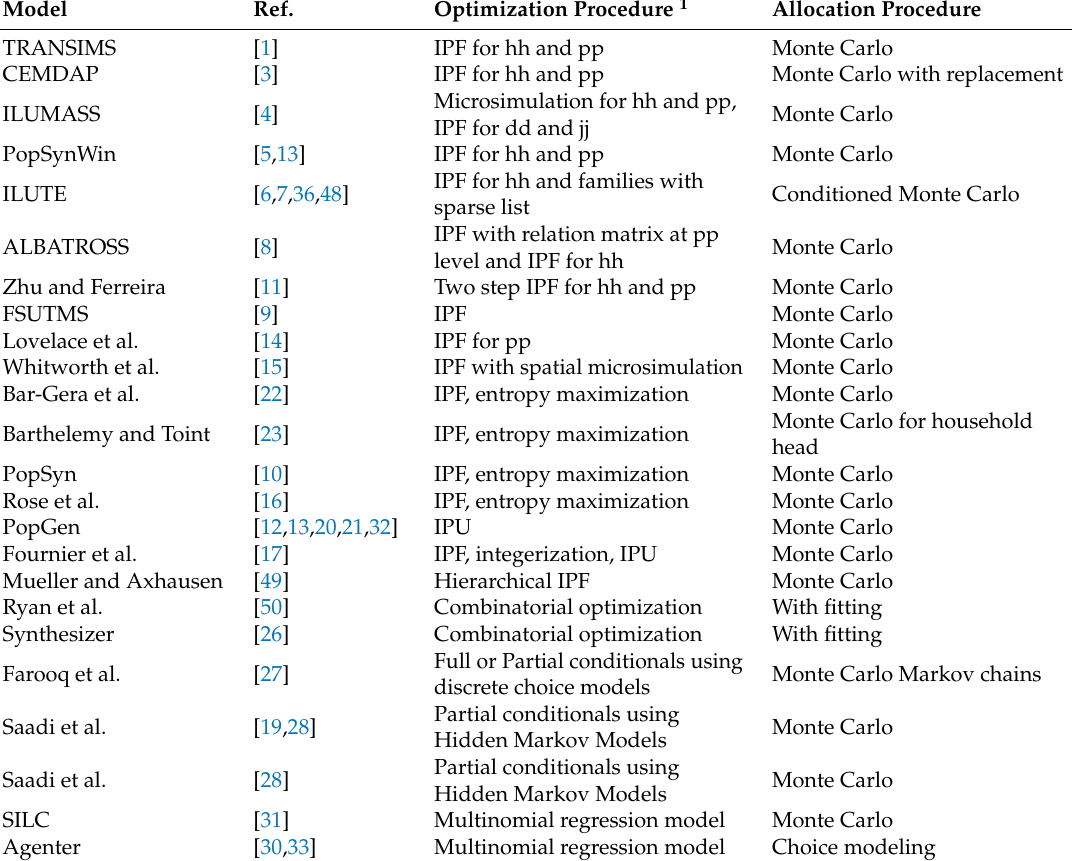
Table A1. Summary of previous population synthesis based on optimization